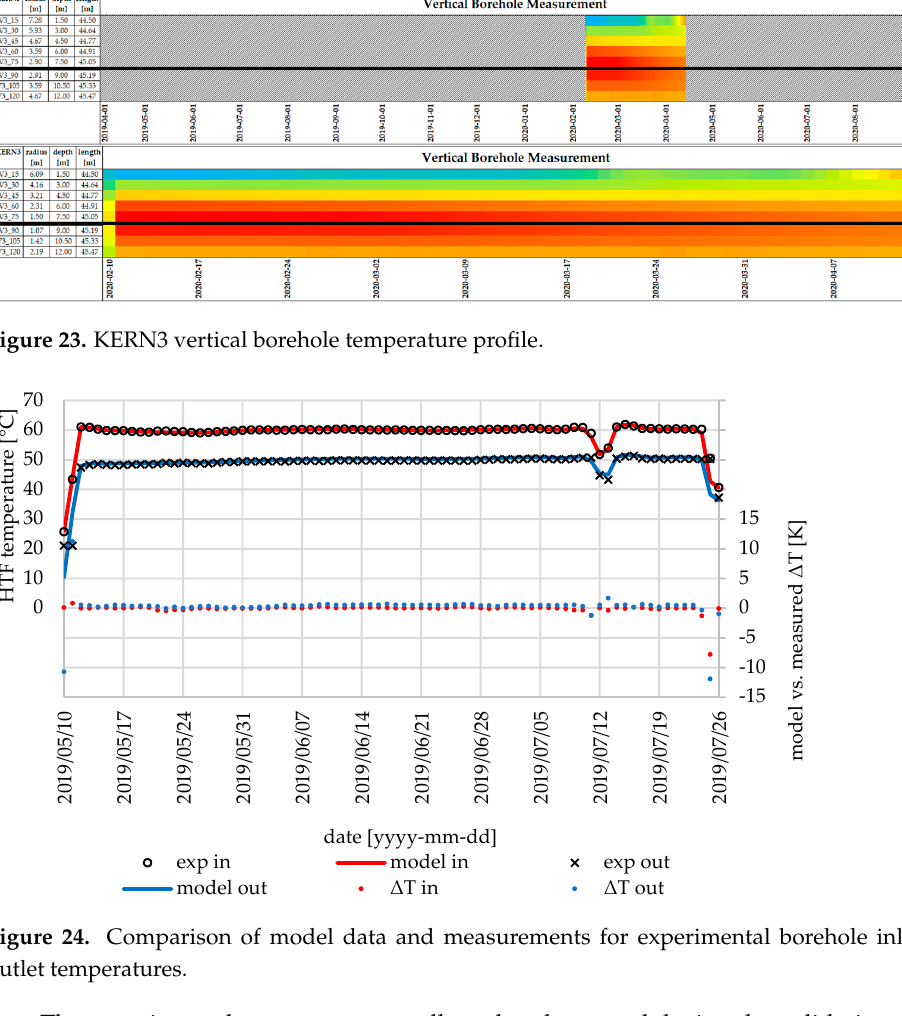
Figure 22. KERN2 vertical borehole temperature profile.